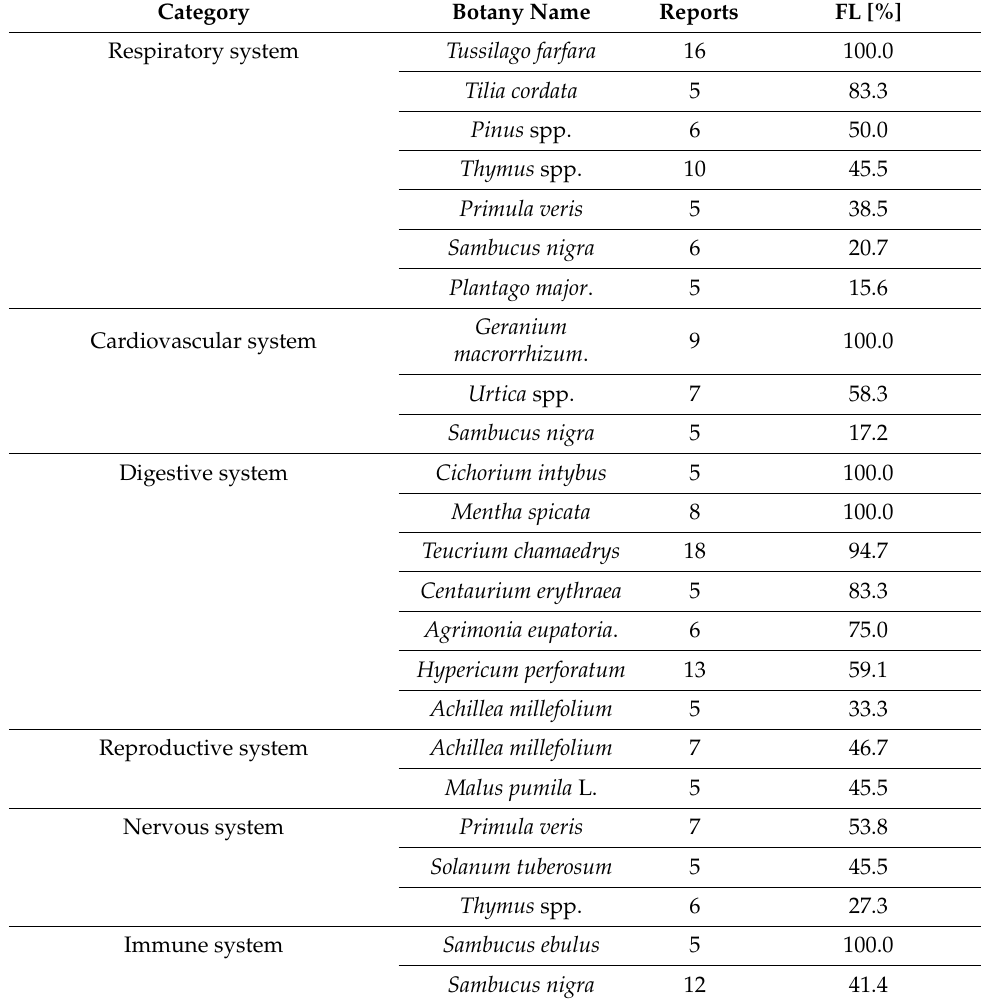
Table 3. FL by diseases categories for Central Rhodopes (number of reports >